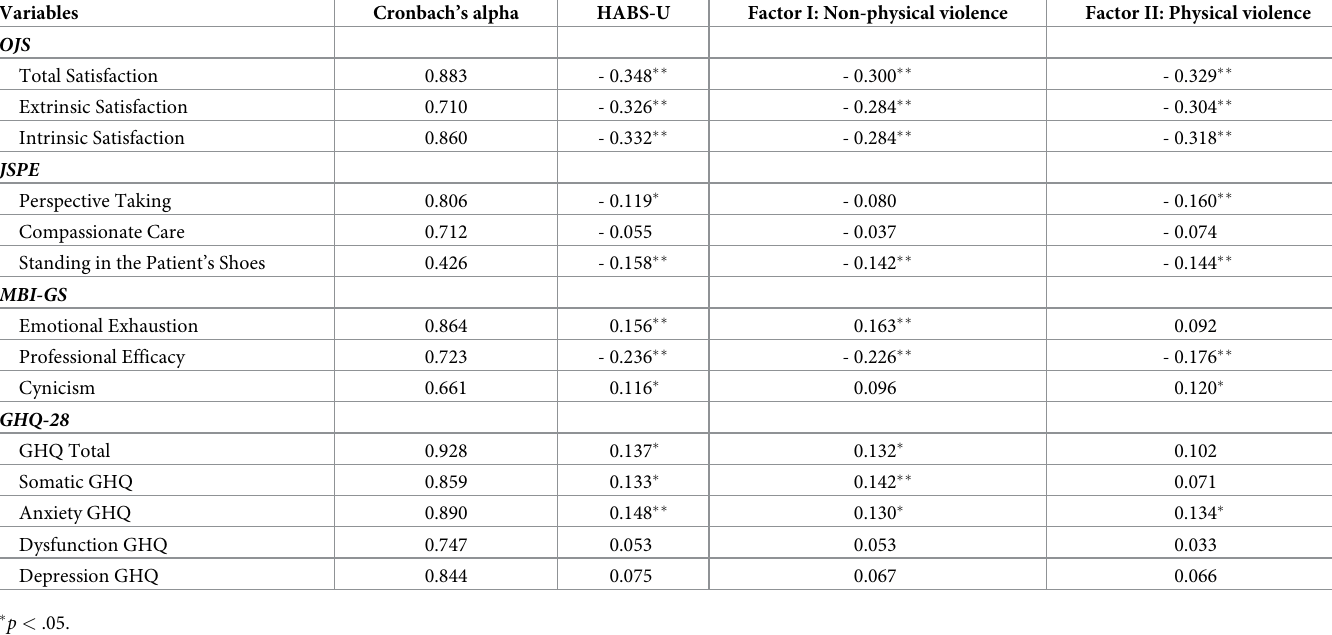
The CFA supported the model of two correlated factors of the HABS-U-MH that had been identified by the EFA. The fit index values were adequate, CFI = 0.983, TLI = 0.978, RMSEA = 0.039, 95% CI [0.027, 0.051]. All the items presented loadings between 0.625 (Item 8, “Anger because of health care delay”) and .961 (Item 6, “Users have even shoved me, shook me, or spit at me”) (Fig 1). In the six items of Factor 1, the factor loadings ranged between 0.625 and 0.889, whereas in the four items of Factor 2, the factor loadings ranged between 0.851 and 0.961. Cronbach’s alpha coeffi- cients were 0.877 for Factor I (Non-physical violence) and 0.841 for Factor II (Physical violence). Table 4. Cronbach alphas and correlations between factors and psychosocial